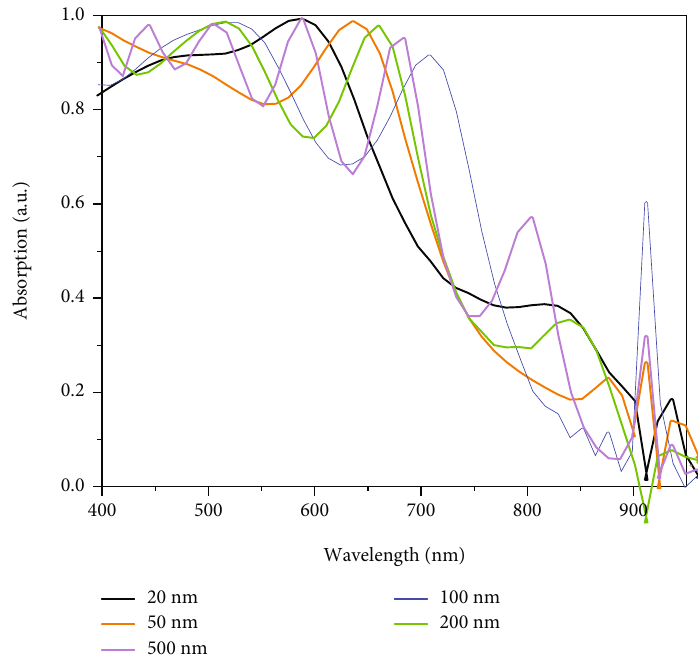
Figure 5: The spectral absorption of PSC with thickness variations of 0.32% Fe-TiO Table 1: The comparison of absorption performance at 446 nm of wavelength for di ff erent TiO Structure ETL thickness Absorption FTO/Er-TiO /MaPbI 2 3